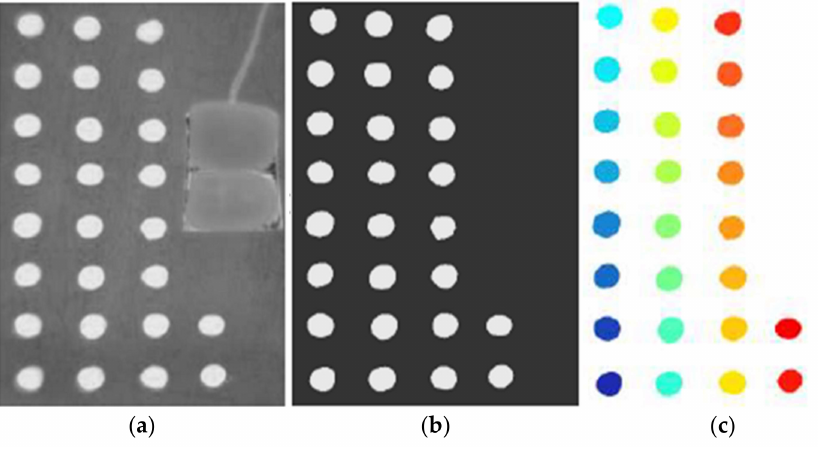
Figure 2. Steps of the image treatment process: ( a ) raw infrared image; ( b ) distinction between samples and background through segmentation; ( c ) identification of individual samples through